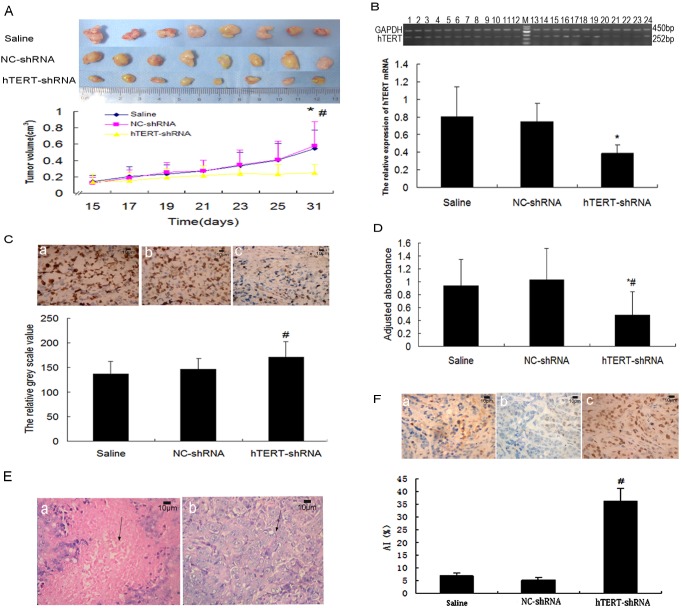
Effects of hTERT-shRNA on SW480 tumor growth, apoptosis and telomerase activity in vivo.(A) hTERT-shRNA inhibits tumor cell growth. Tumor growth at 31 days was significantly slower in tumors treated with hTERT-shRNA than in tumors treated with saline (*P<0.05) or NC-shRNA (#
P<0.01). (B) Histopathological examination of SW480 tumor tissue grafted onto nude mice and treated with hTERT-shRNA. Tumor tissue was biopsied at 31 days and stained with hematoxylin-eosin. The arrow in (a) indicates sheet necrosis; the arrow in (b) indicates inversion of the nucleoplasm to cytoplasm volume, together with mitotic pathology. Magnification, ×200. (C) RT-PCR analysis to measure hTERT mRNA expression in tumor tissue treated with saline (lanes 1–8), NC-shRNA (lanes 9–16), or hTERT-shRNA (lanes 17–24). M, 100-bp DNA ladder. The relative expression of hTERT mRNA was significantly lower in the hTERT-shRNA mice. *P<0.05, compared with the saline and NC-shRNA groups. (D) Immunocytochemistry of hTERT protein (stained brown) in tumor tissue treated with (a) saline, (b) NC-shRNA, or (c) hTERT-shRNA. Magnification, ×200. Higher greyscale values indicate lower protein levels. The relative expression of hTERT protein was significantly lower in hTERT-shRNA mice. #P<0.01, compared with the saline and NC-shRNA groups. (E) Effect of hTERT-shRNA on telomerase activity in vivo. The adjusted absorbance (450 nm - 630 nm) was significantly lower in tumors treated with hTERT-shRNA than in tumors treated with saline (*P<0.05) or NC-shRNA (#
P<0.01). (F) Effects of hTERT-shRNA on apoptosis. Tumors were injected regularly with (a) saline, (b) NC-shRNA or (c) hTERT-shRNA, then biopsied and stained with diaminobenzidine (brown); nuclei were counter-stained with hematoxylin (blue). Images are representative results of three independent experiments. Magnification, ×200. The apoptotic index (AI) was significantly higher in tumors treated with hTERT-shRNA than in tumors treated with saline or NC-shRNA. #
P<0.01, compared to the two control groups.